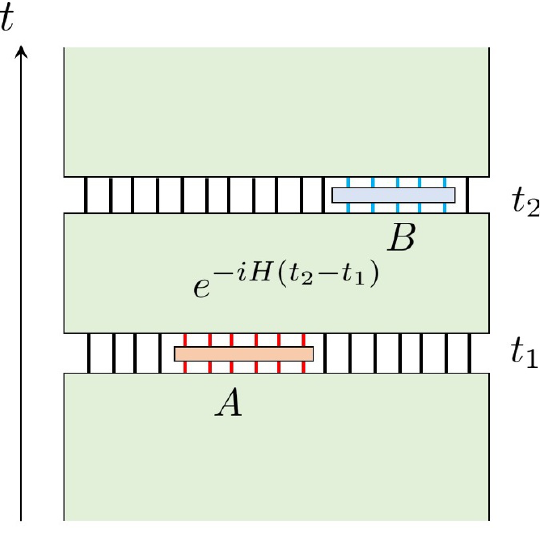
Figure 2 . Depiction of regions A at time t 1 and B at time t 2 for a spin chain. The causal in(cid:13)uence is measured by inserting a unitary operator U A in region A (orange box) and studying its e(cid:11)ect on the measurement of an arbitrary operator O B in B (blue